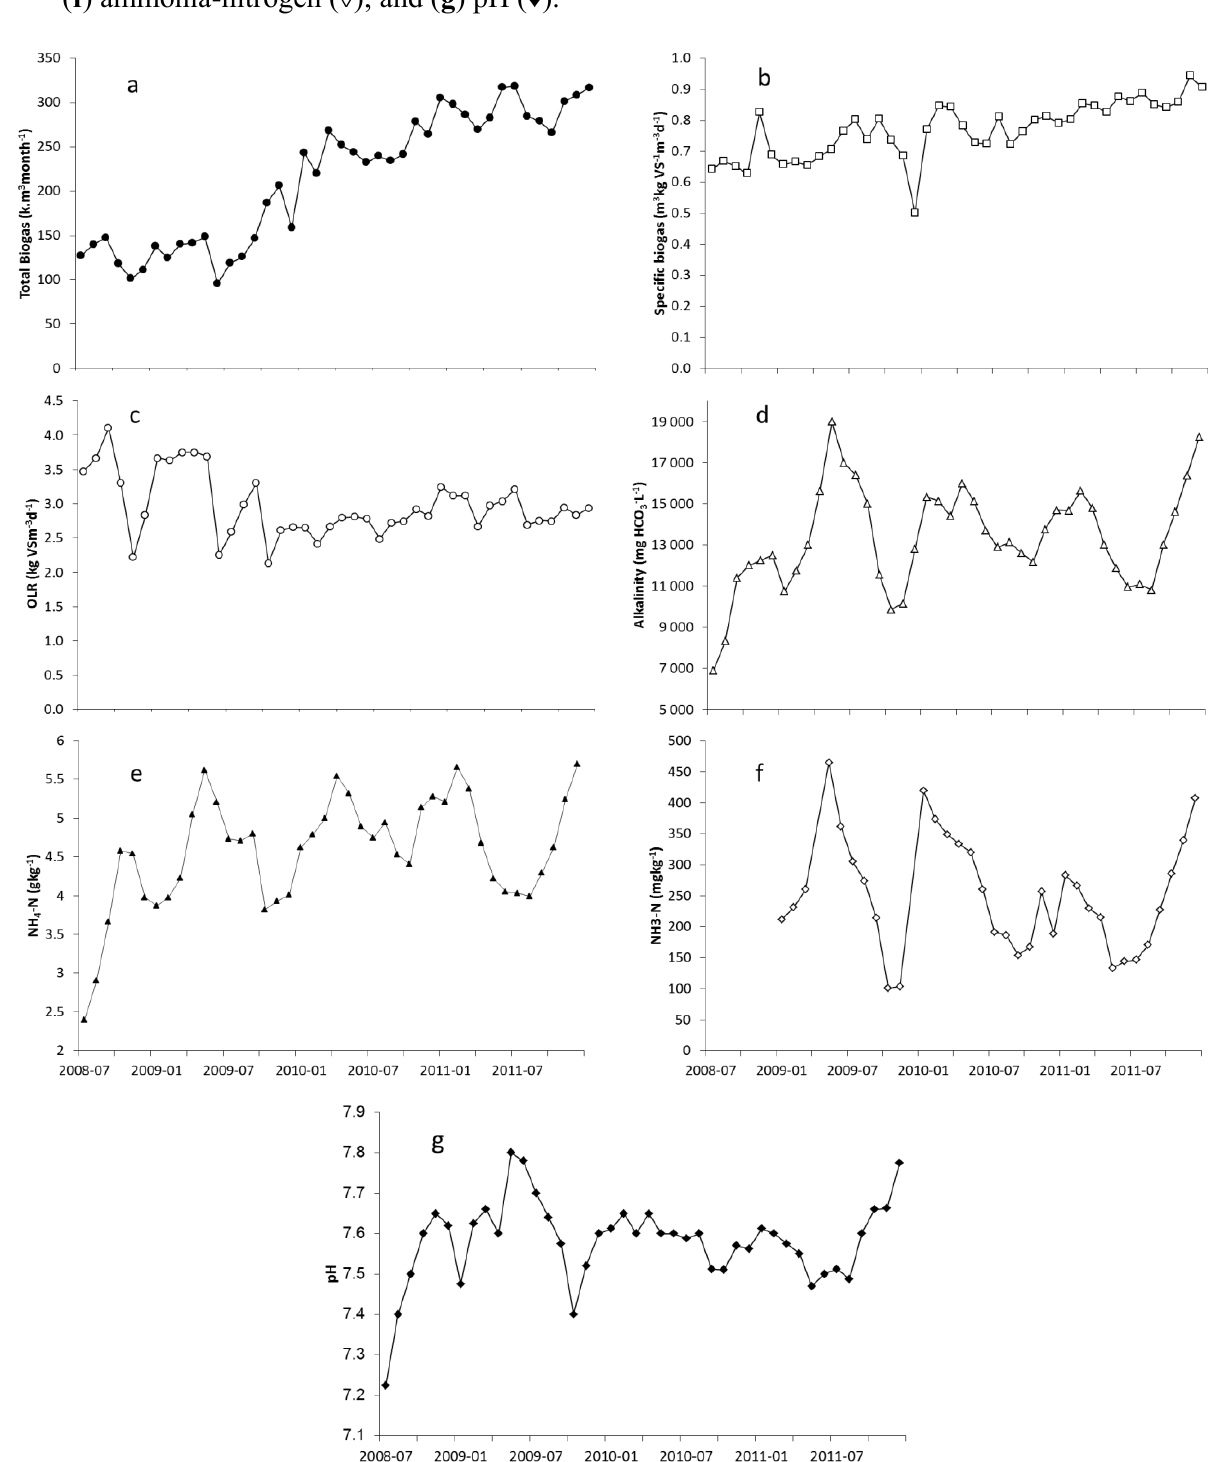
Figure 1. Mean monthly values of different process parameters at the